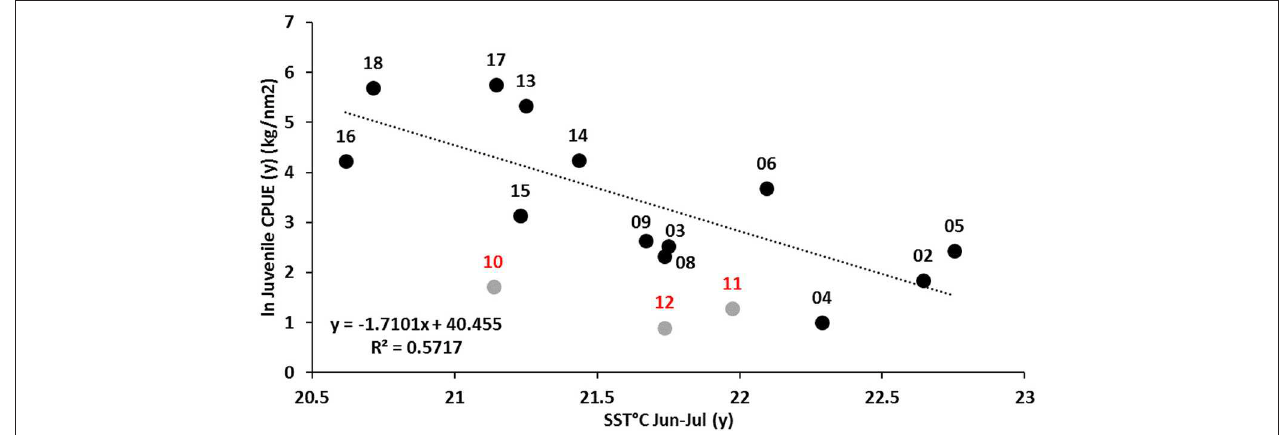
FIGURE 8 | Relationship between log transformed juvenile crab catch rate during November (y) and mean SST during May-July (y) for all years 2002–2018 excluding 2010–2012 as they were affected by 2011 MHW and subsequent low spawning stock levels. Survey data is not available for 2007.